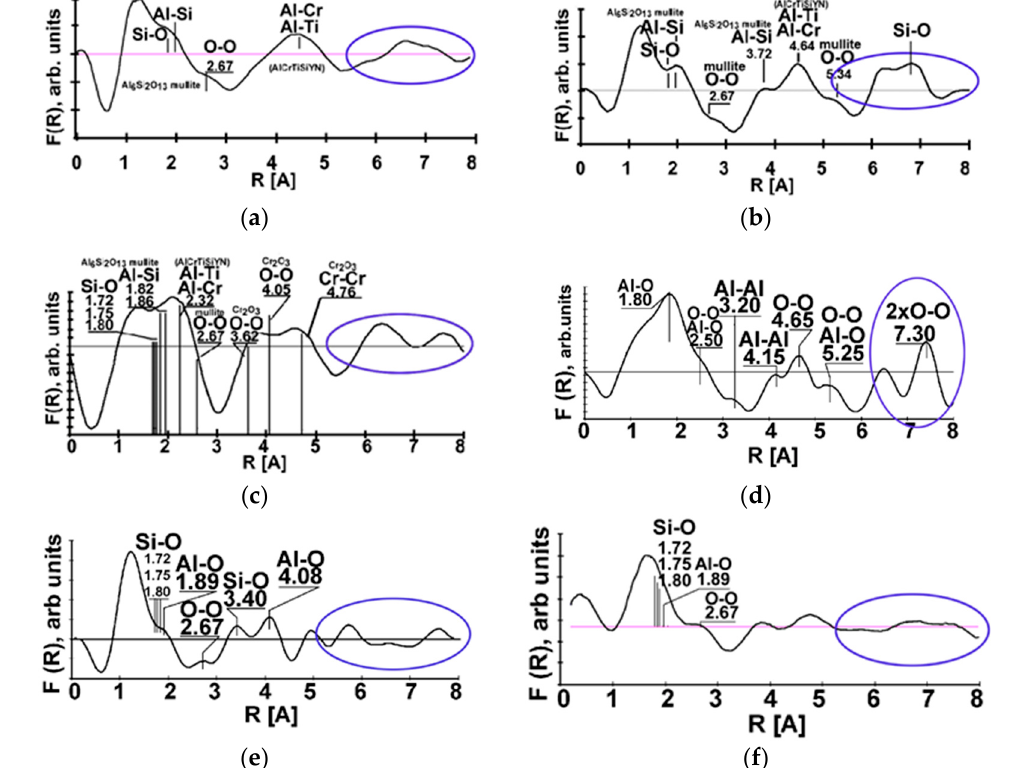
Figure 6. The evolution of the atomic coordination R [Å] in the tribo-oxides vs. cutting length: ( a ) 2 m;